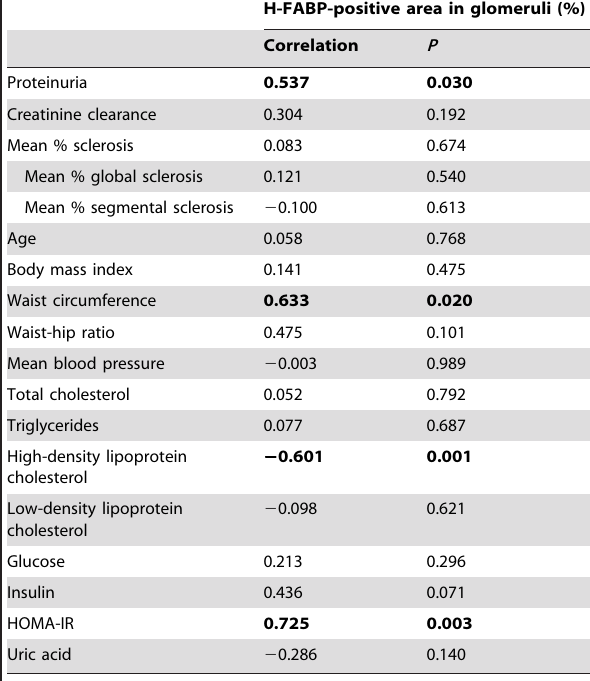
Table 1. The correlation of H-FABP expression with renal damage and metabolic disturbance in patients with obesity- related glomerulopathy.